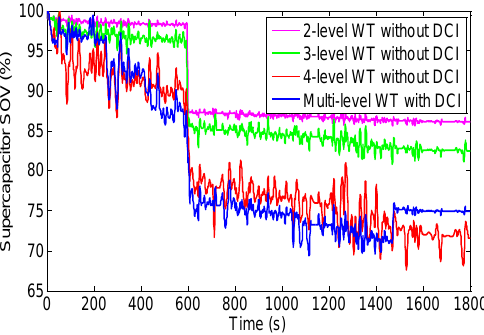
Figure 28. The state of voltage (SoV) comparison of supercapacitor bank. WT, wavelet transform; DCI, driving cycle identification.